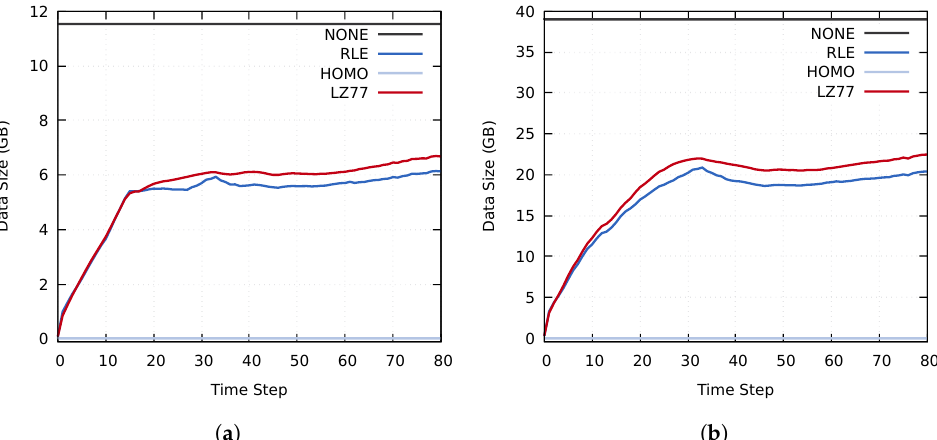
Figure 9. The size of the compressed data transferred during the distribution stage on ( a ) cluster A and ( b ) cluster B, using the MF, MY, and MZ data